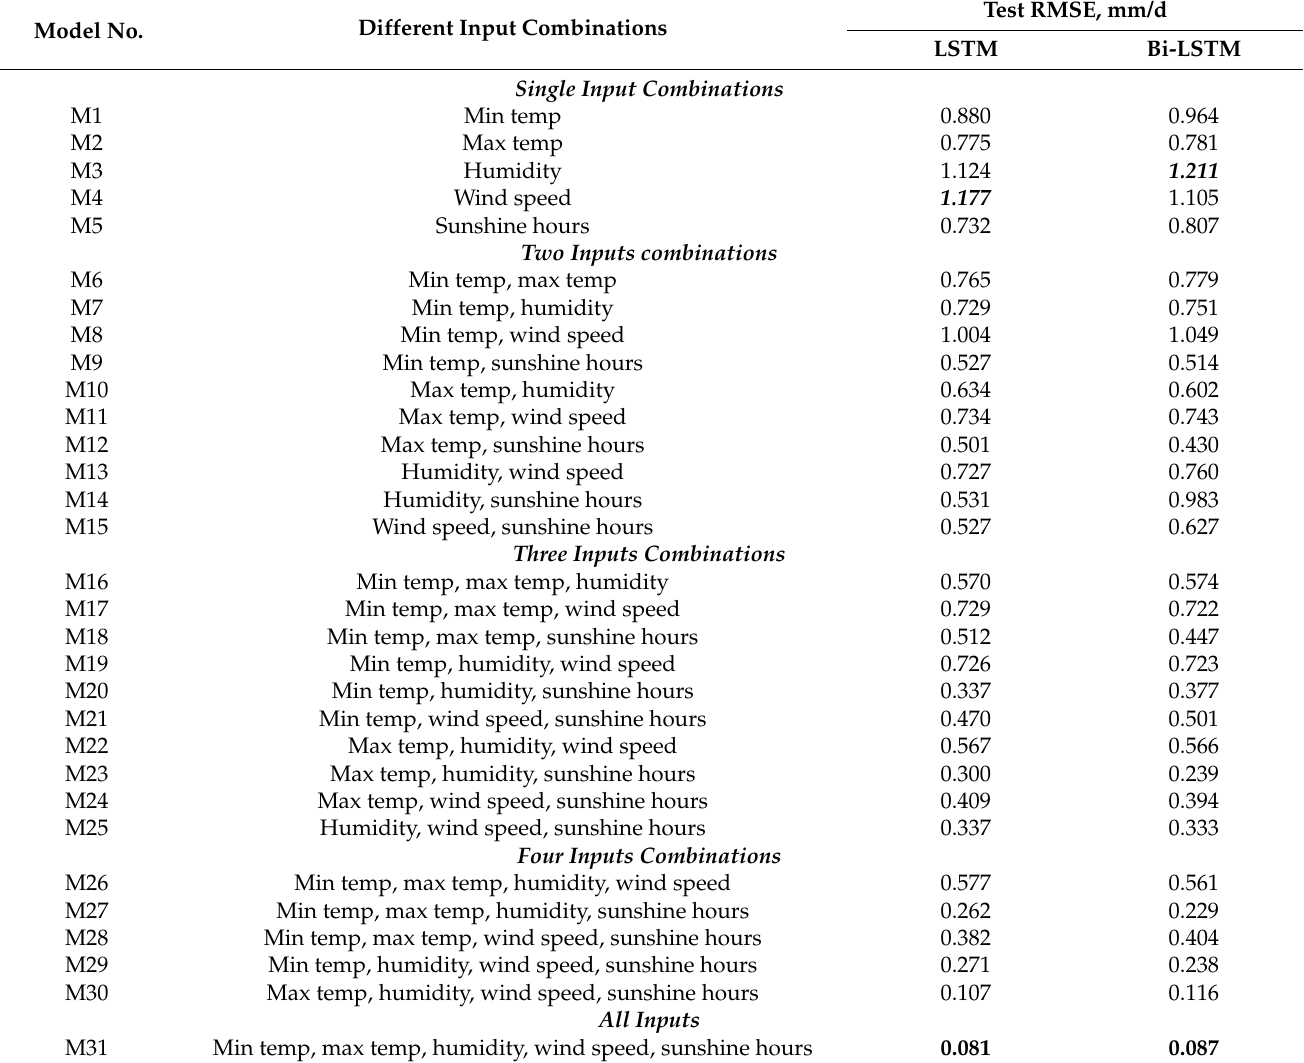
Table 5. Prediction errors of deep learning-based ET 0 models (LSTM and Bi-LSTM) with different input combinations on the test